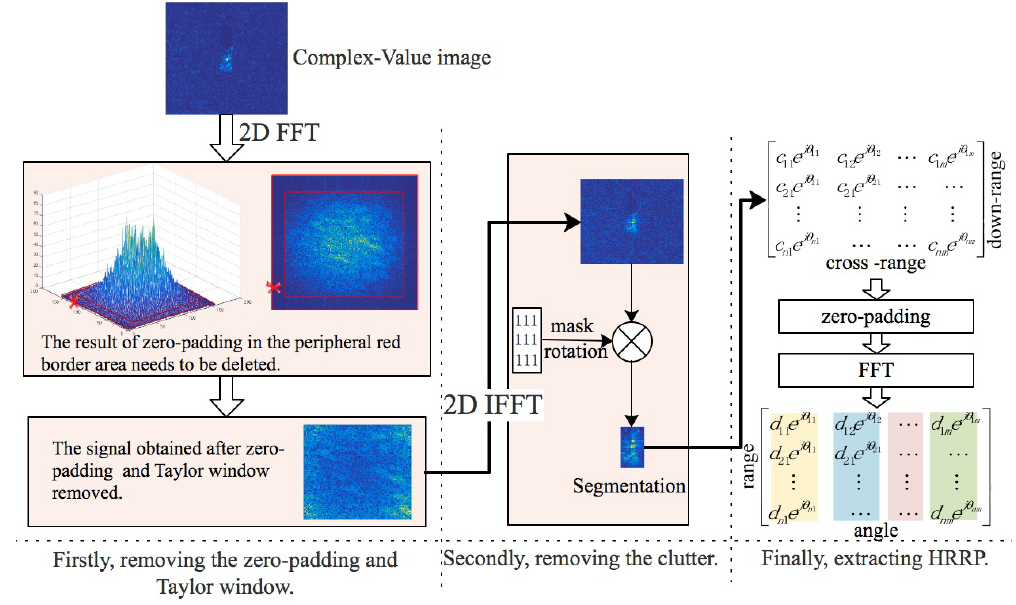
Figure 7. The procedure from a SAR image to